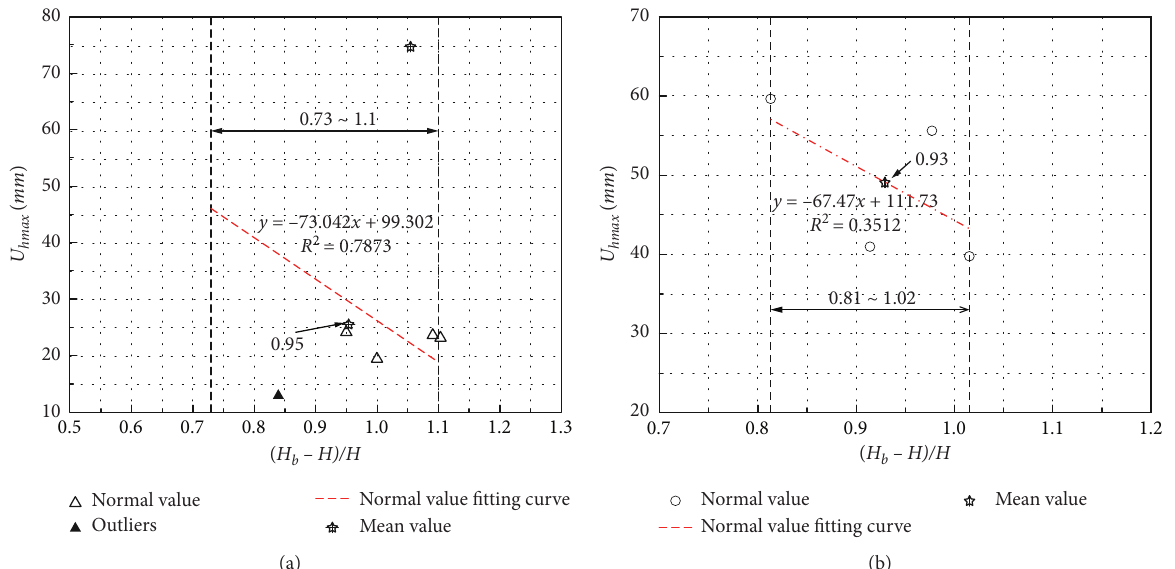
Figure 4: Relationship between insertion ratio and maximum lateral deformation of the foundation pit. (a) Hangzhou. (b) Shanghai.